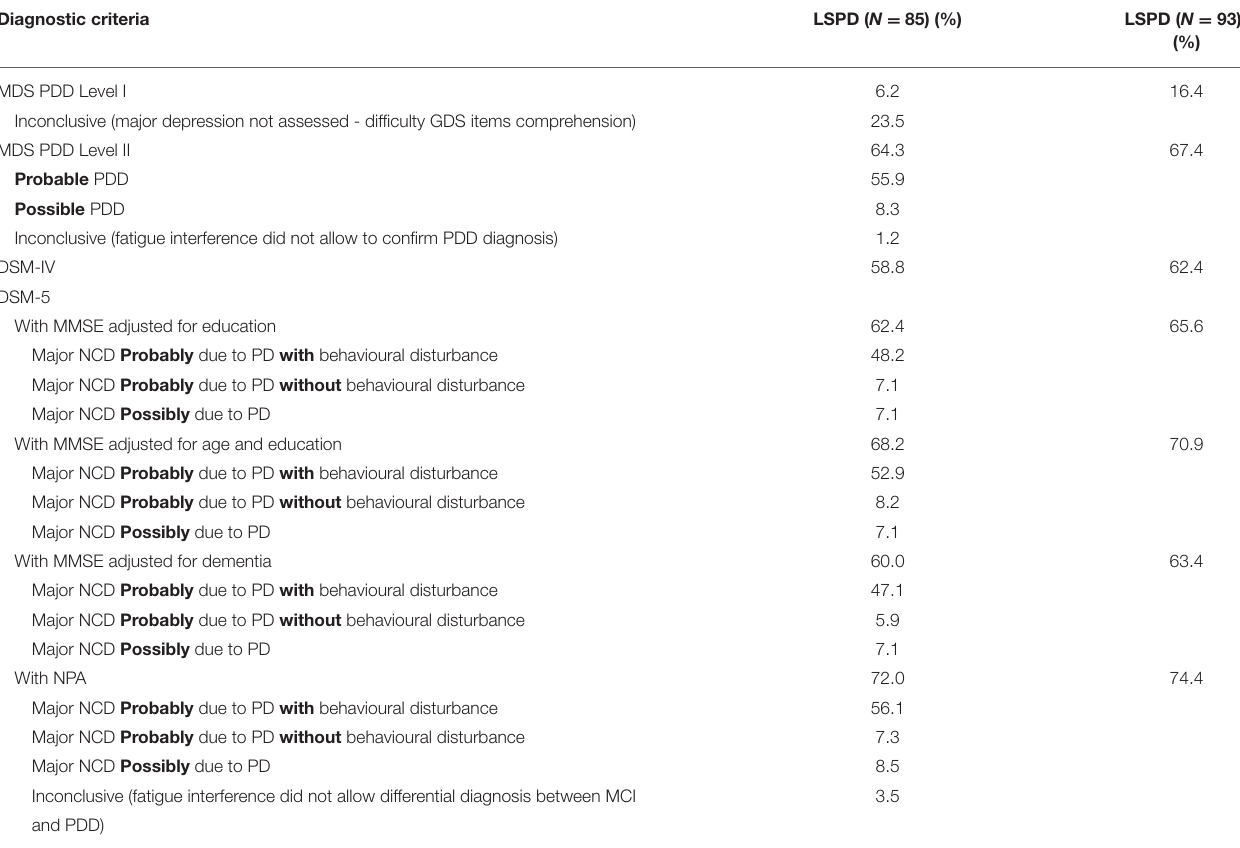
TABLE 4 | Dementia frequency according to different diagnostic criteria. Diagnostic